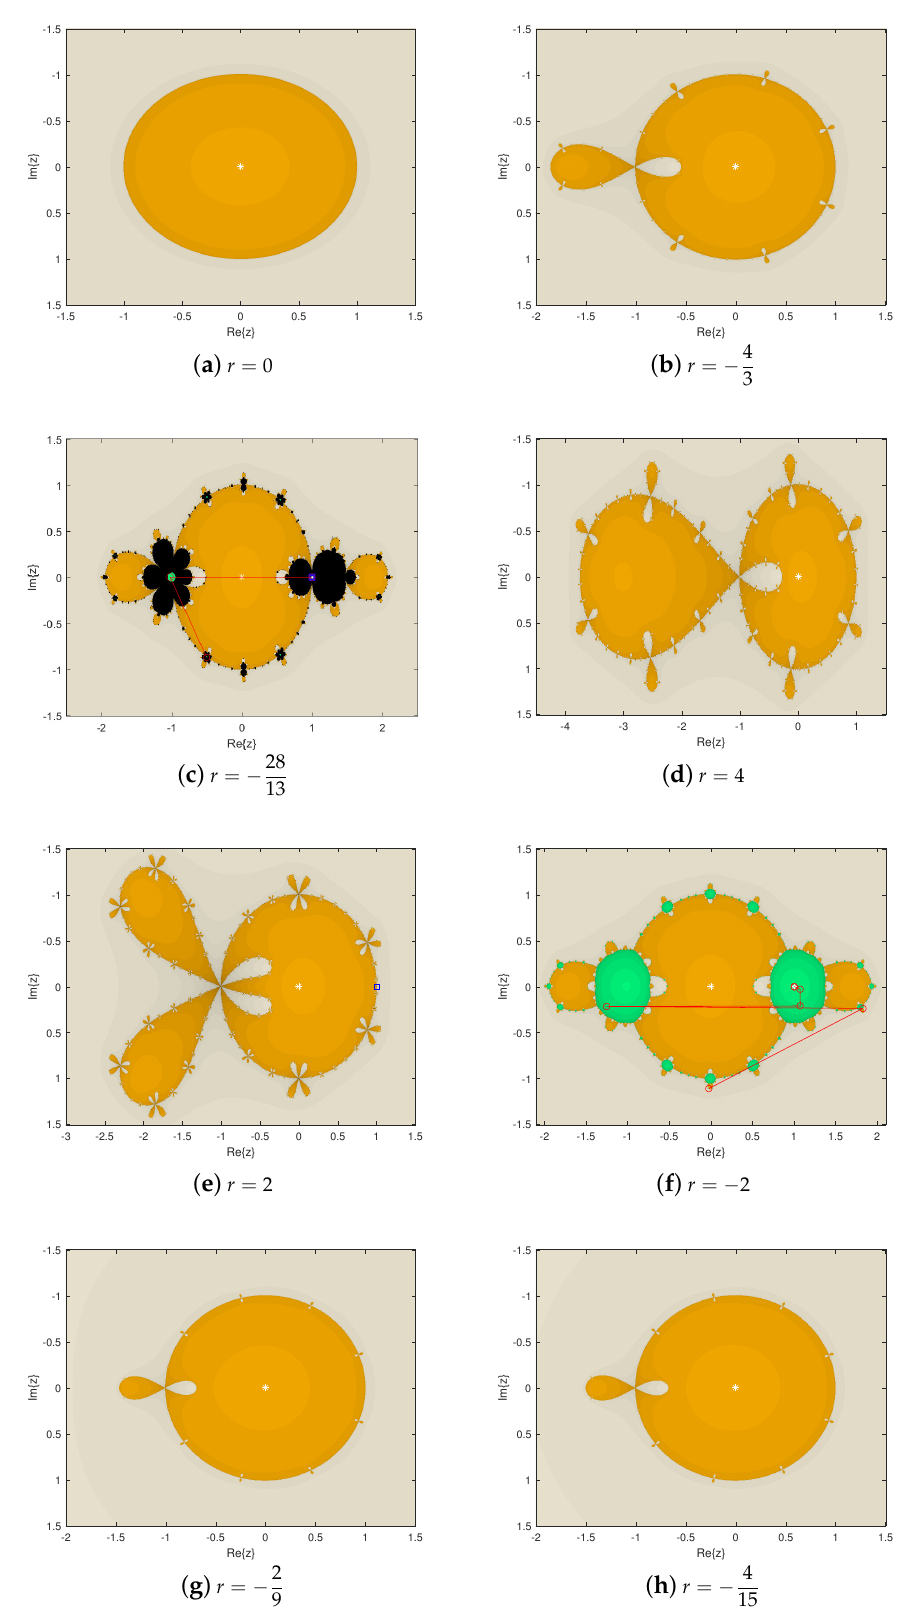
Figure 7. Dynamical planes of special r